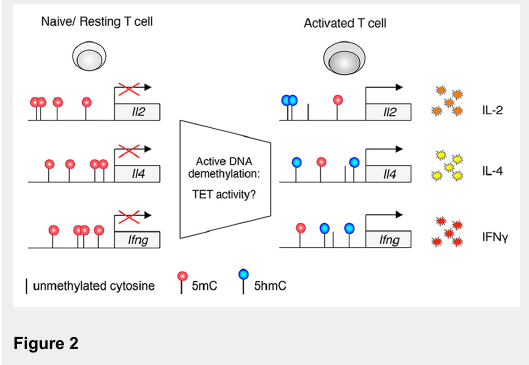
DNA methylation dynamics regulate cytokine production in T lymphocytes. DNA methylation modulates cytokine production upon T cell activation, and active demethylation processes (independent of cell replication) have been shown to act at some cytokine loci. Hypothetically, these processes may involve TET proteins as an underlying mechanism of demethylation. 5hmC = 5-hydroxymethylcytosine; 5mC = 5.methylcytosine; IFNγ = interferon-gamma; IL = interleukin; TET = ten-eleven